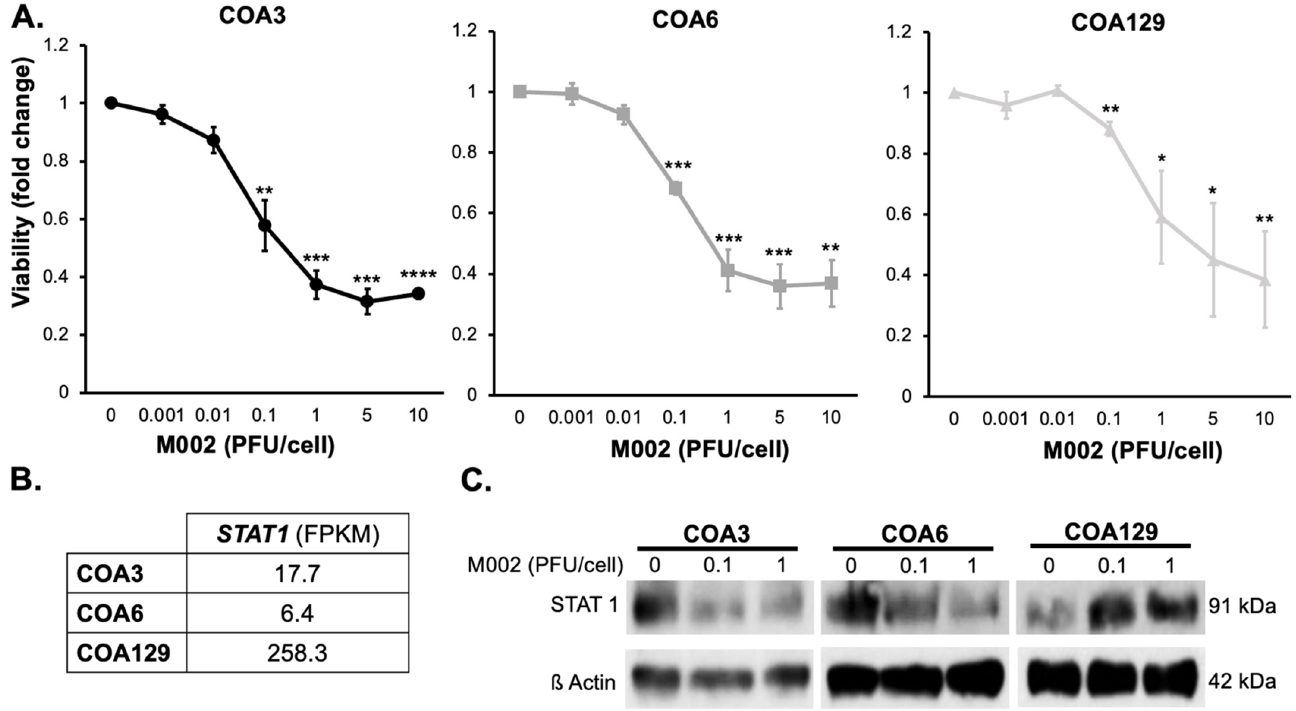
Figure 3. M002 decreased neuroblastoma PDX viability and affected STAT1 expression. ( A ) COA3, COA6, and COA129 were treated with increasing MOIs of M002 (0, 0.001, 0.01, 1, 5, 10) for 72 h and cell viability was measured with alamarBlue ® assay. There was a significant decrease in viability in COA3 (left), COA6 (middle), and COA129 (right) with M002 treatment (* p ≤ 0.05, ** p ≤ 0.01, *** p ≤ 0.001, **** p ≤ 0.0001, compared to 0 PFU/cell). ( B ) RNA abundance of STAT1 was examined with sequencing in untreated COA3, COA6, and COA129 cells. There was more STAT1 RNA in COA129 cells. ( C ) STAT1 expression was assessed following M002 infection. COA3, COA6, and COA129 cells (10 6 ) were treated with increasing MOI of M002 (0, 0.1, 1) for 72 h. STAT1 expression was analyzed via immunoblotting (separate blots for each PDX). There was a decrease in STAT1 expression in COA3 (left) and COA6 (middle), but an increase in STAT1 in COA129 (right) following infection with M002. Full Western blot scans provided and densitometry values calculated for each blot (Figure S1) Data are reported as mean ± SEM and represent at least three biologic replicates. A Student’s t -test was used for statistical analysis. (Figure S2)